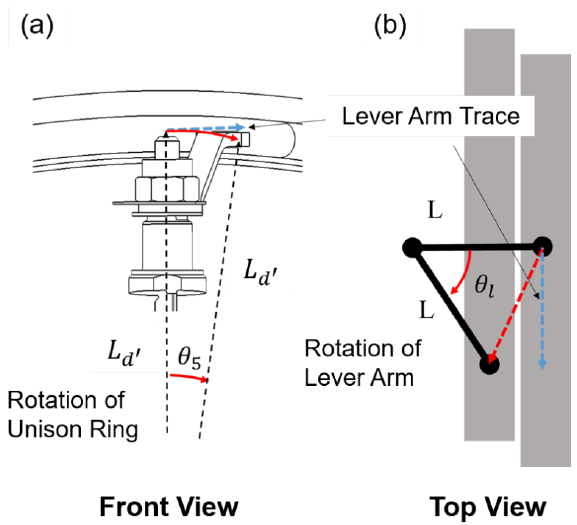
Figure 3. Lever arm kinematics. ( a ) Front view; ( b ) Top view.